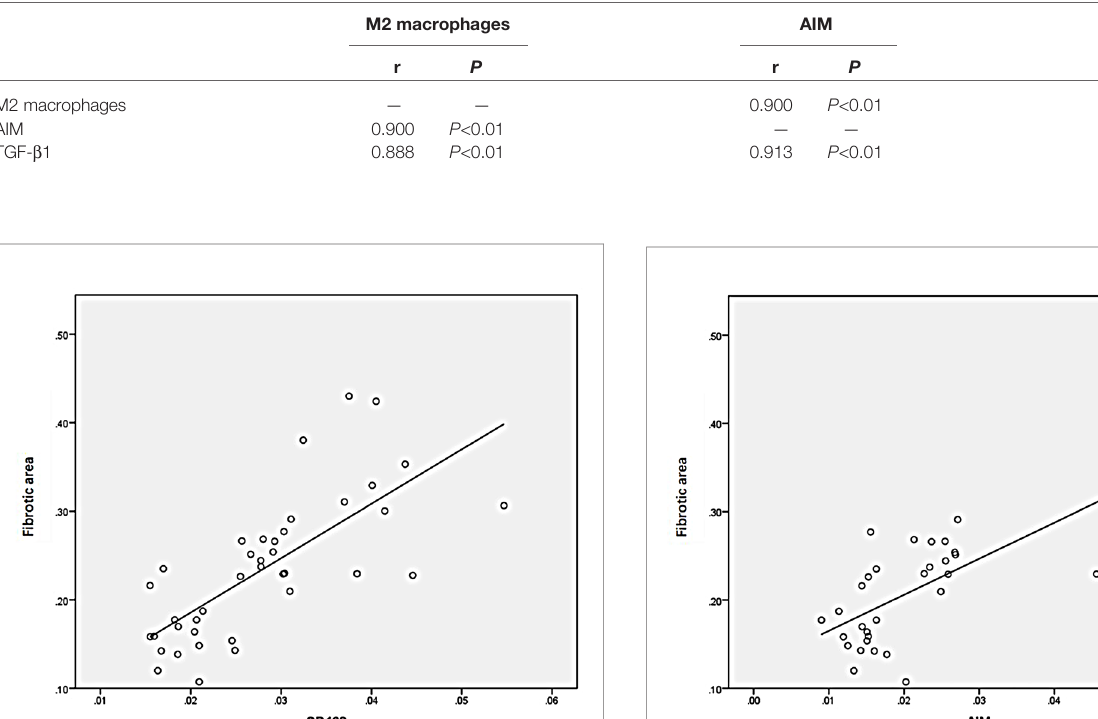
TABLE 2 | AIOD of M2 macrophages, AIM, TGF- b 1 among IgAN patients with different pathological stage.